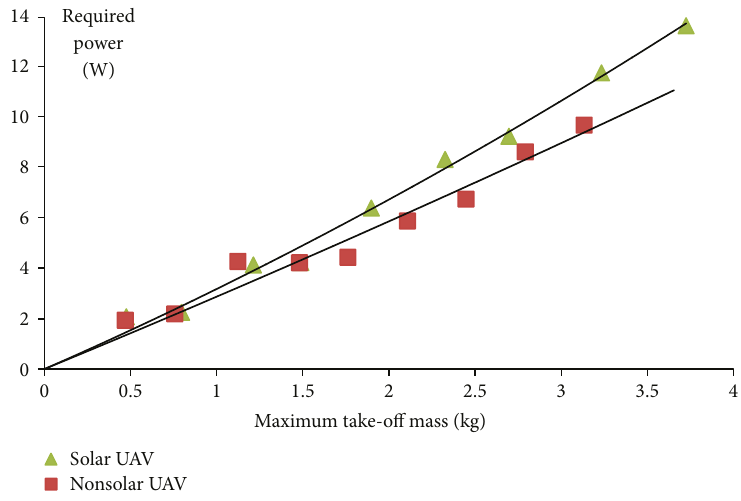
Figure 9: Maximum take-o ff mass versus required power of the solar and nonsolar UAVs. Table 1: Comparison of current and previous small solar-powered UAV